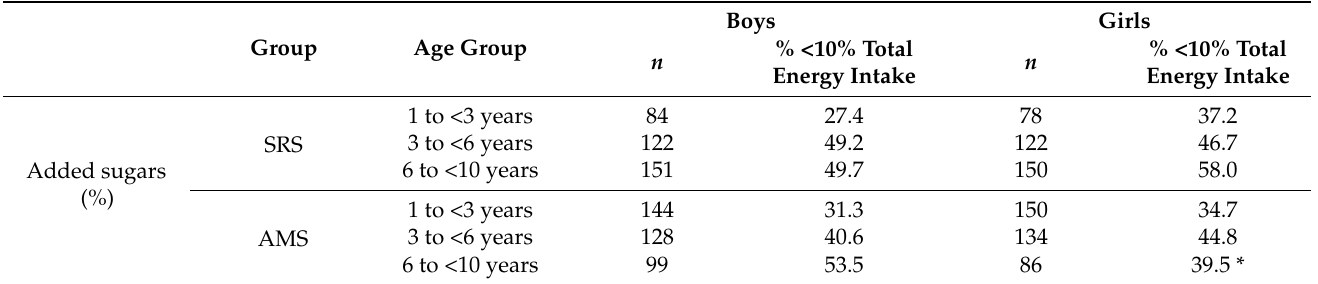
Table 3. Prevalence of adequacy (percentage of population below 10% total energy intake) in the Spanish Pediatric Population (EsNuPI) study.